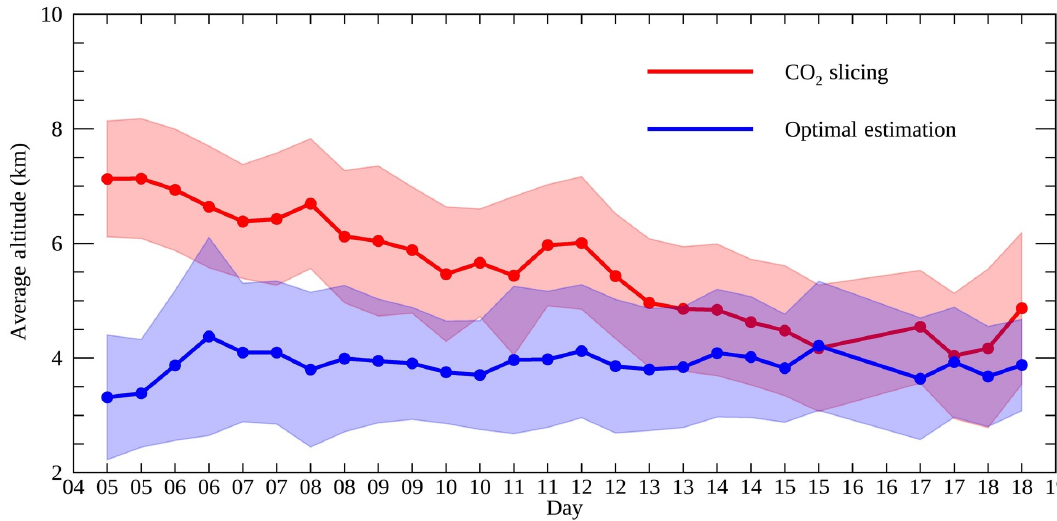
Figure 9. Time series showing how the average retrieved height for the CO 2 slicing and optimal estimation techniques varies during the Eyjafjallajökull eruption. The shaded polygon represents 1 standard deviation from the mean.